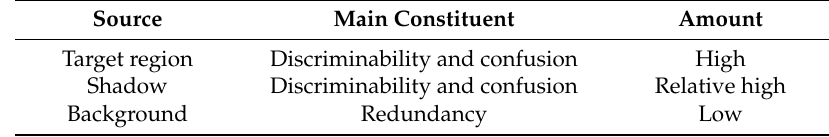
Table 1. Information in the target region, shadow and background of the SAR image.